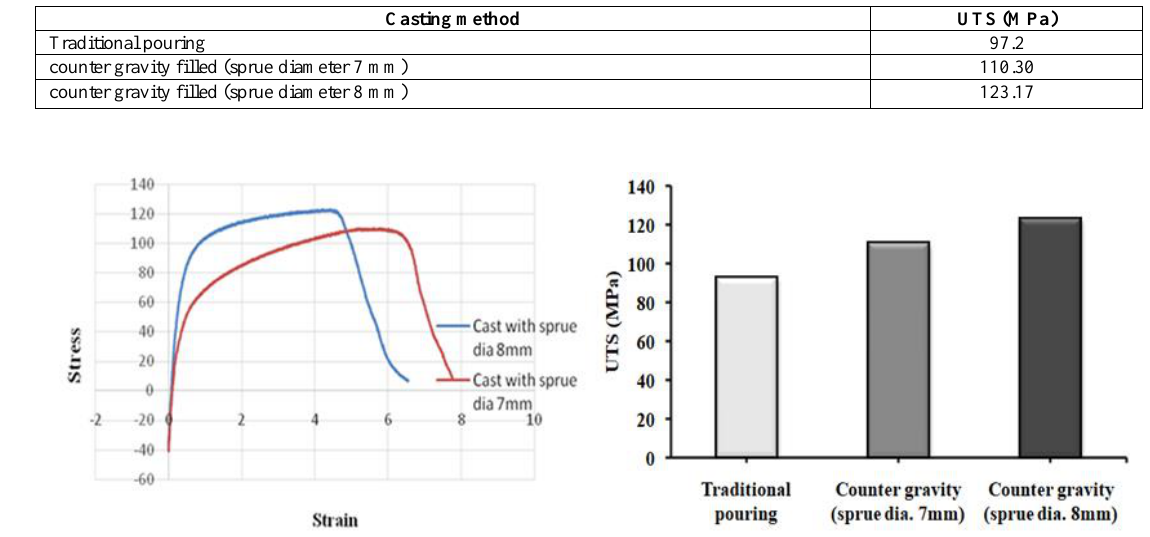
Figure 10. Stress strain curves and UTS of cast specimens